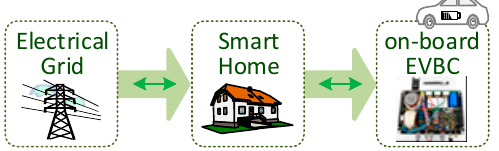
Figure 4. On-board EVBC: Grid-to-vehicle (G2V) operation mode.